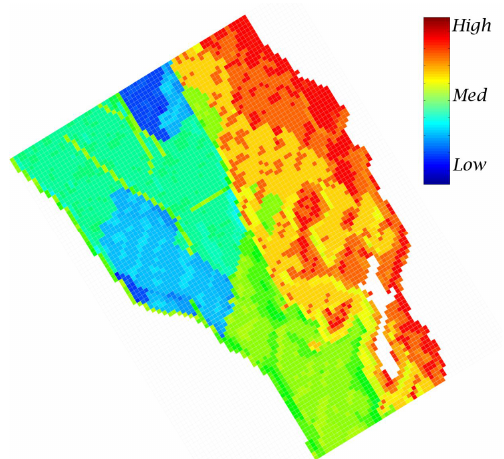
Figure 3: qualitative recharge. The colour scale reflects the different attitude to recharge of the zones, Fig. 3. Qualitative recharge. The colour scale reflects the differ- ranging from high (red) to low (blue). ent attitude to recharging the zones, ranging from high (red) to low (blue).